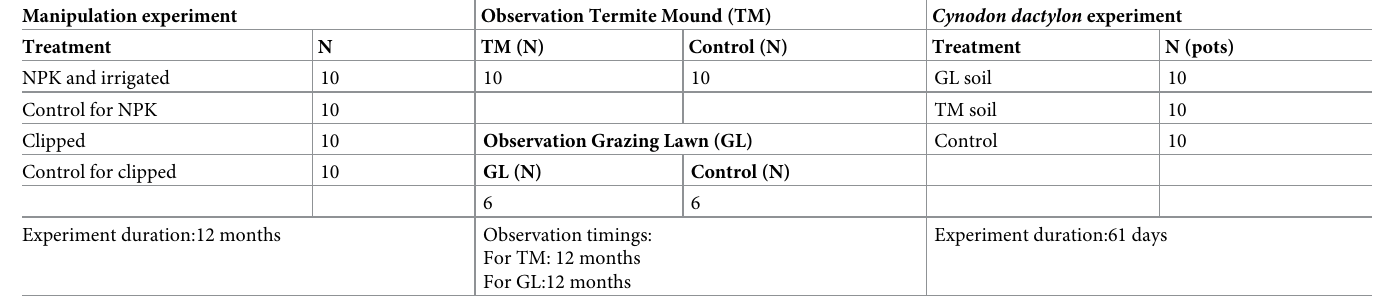
Table 2. Sample sizes (N) for plots that were involved in the manipulation experiment, observation field plots and C . dactylon experiment. Manipulation experiment includes plots that were fertilized and their controls, clipped plots and their controls. The observational study shows plot numbers around termite mounds, grazing lawns and their controls. Further, C . dactylon pot experiments show the number of pots from grazing lawn derived soils, termite mound derived soils and control soils. Experi- ment duration has also been indicated at the bottom.